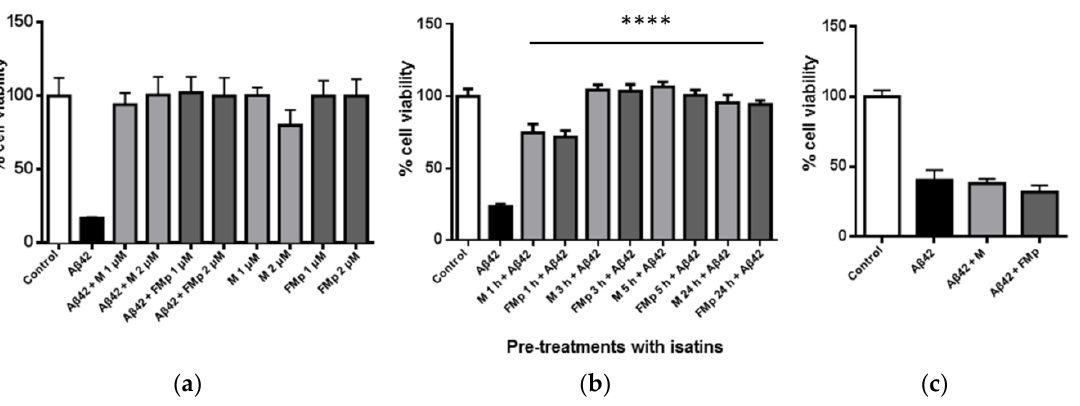
Figure 2. ITSC derivatives effectively protect against neurotoxicity caused by A β 42 in SK-N-SH cells: ( a ) Mixtures of either M or FMp (1 and 2 µ M) with A β 42 (1 µ M) were incubated for 24 h at 37 ◦ C and then added to cells for 24 h. Negative control cells were treated with ITSCs alone in the same conditions. ( b ) Cells were treated with either M or FMp (1 µ M) for 1, 3, 5 and 24 h prior to the addition of A β 42 (1 µ M) for 24 h. ( c ) Cells were treated for 24 h with 1 µ M of A β 42 followed by a 24 h treatment with 1 µ M of M or FMp. Significance relative to control ( a ) and to A β 42 ( b , c ). Results were expressed as the mean ± s.d. for at least three independent experiments and analyzed using one-way ANOVA (**** p < 0.0001).